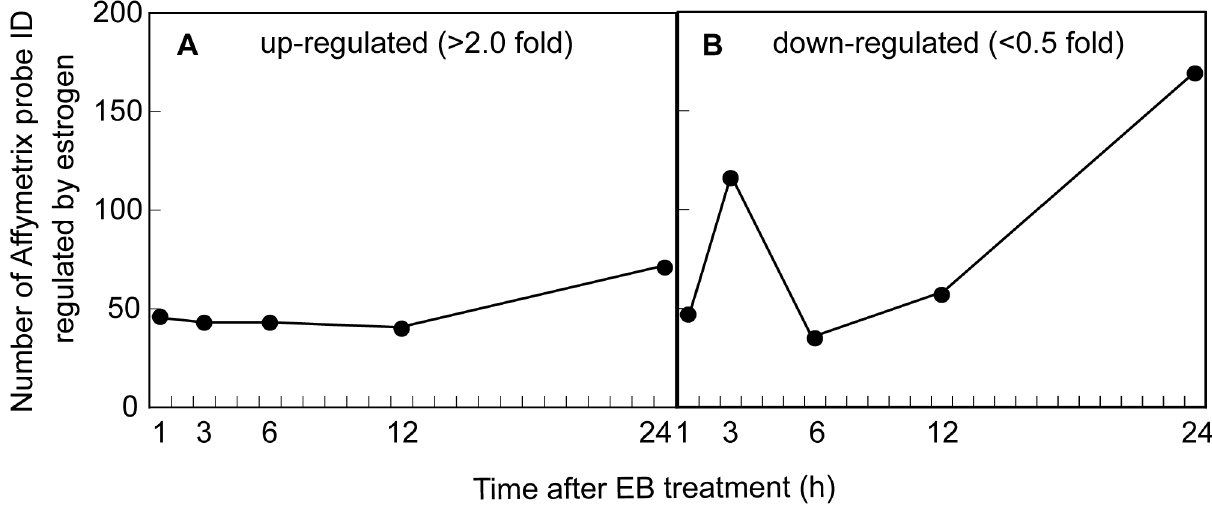
Figure 1. The number of Affymetrix probe ID, expressions of which were increased or decreased by neonatal estradiol bezoate (EB) treatment, in the hypothalamus of female mice. A, Numbers of genes showing a 2-fold or greater expression in EB-treated group compared with vehicle-treated control group; B, Numbers of genes showing a 0.5-fold or less expression in EB- treated group compared with vehicle-treated control group. Female mice were subcutaneously treated with EB (7.5 μg) on the day of birth and then the hypothalamus were collected at either 1, 3, 6, 12,or 24 h after the EB treatment. Difference of gene expression between EB- and vehicle-treated control mice was determined by GeneSpring GX 7.3 software. doi: